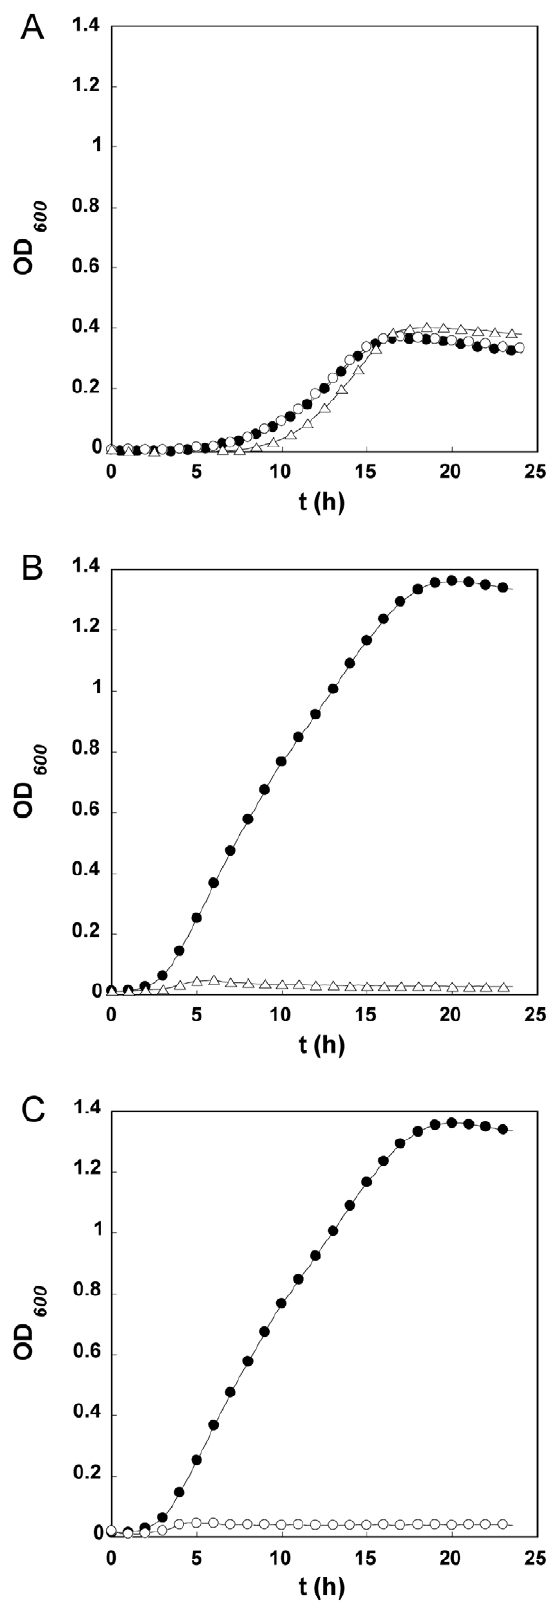
Figure 2. Phenotypic characterization of single gene deletions within L.acidophilus NCFM. Growth profiles are shown on